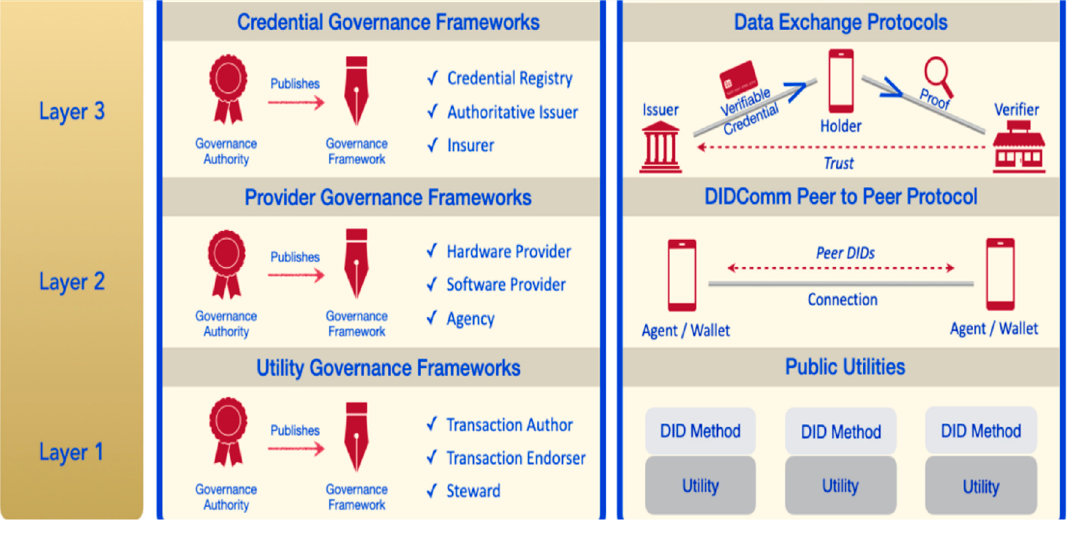
Figure 8. The von-network running in cloud CDM.